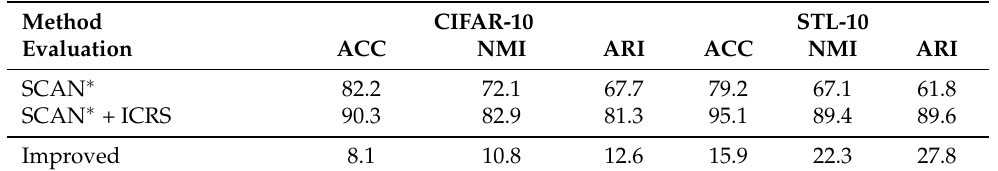
Table 4. SCAN* is the model from SCAN [31] without the self-labeling steps. It is a clustering model based on features extracted from unsupervised representation